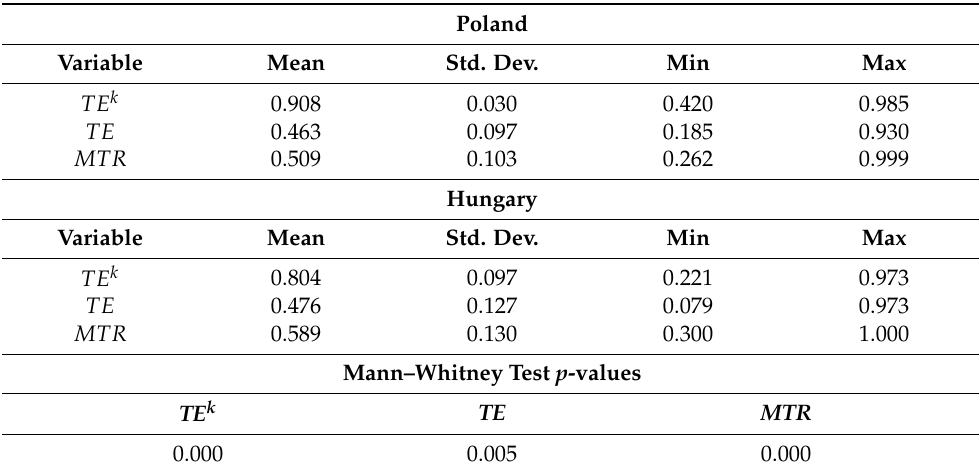
Table 4. Technical efficiency, metafrontier, and metatechnology